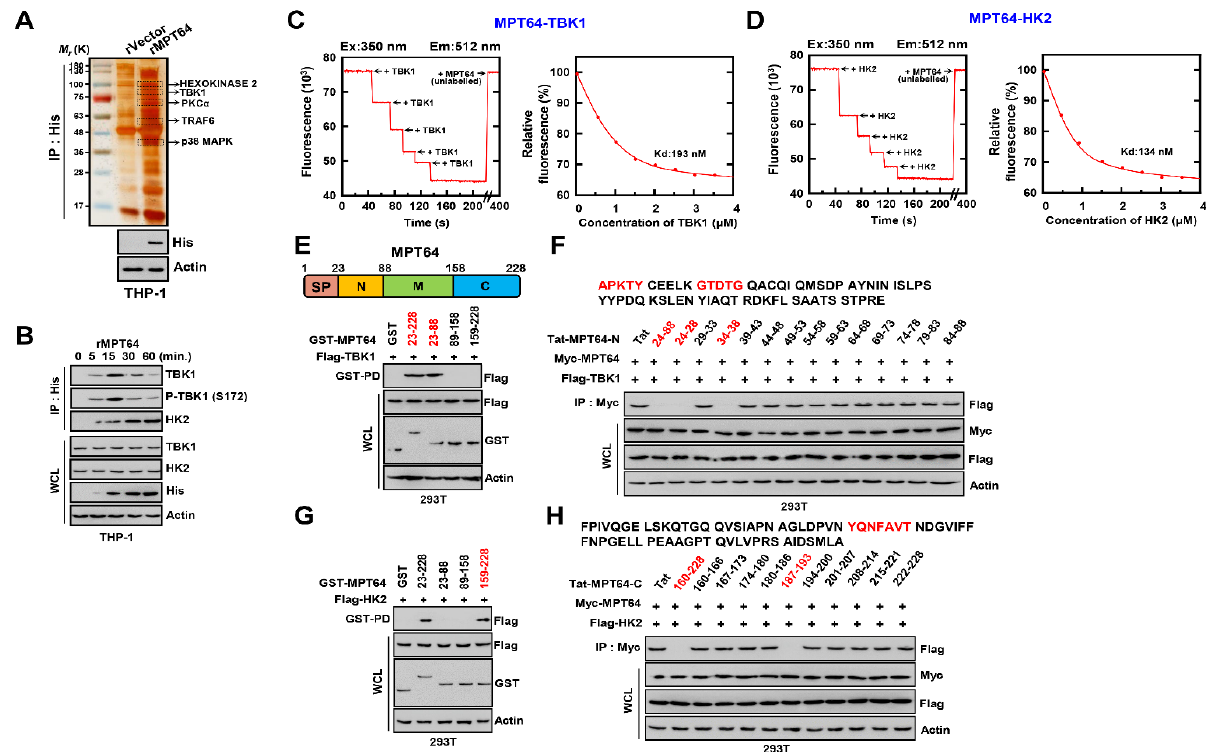
Figure 2. TBK1 and HK2 directly interact with MPT64. ( A ) Identification of TBK1 and HK2 by mass spectrometry analysis in THP-1 cell lysates treated with rMPT64 or rVector. ( B ) THP-1 cells were stimulated with rMPT64 (5 μg mL −1 ) for the indicated times, followed by IP with αHis-agarose bead and IB with αTBK1, αP-TBK1 (S172), αHK2, αHis, αActin. ( C , D ) Titration of fluorescently labelled MPT64 with TBK1 and HK2 (left), with K d (193 and 134 nM), determined by curve fit analysis (right). ( E , G ) Binding mapping. Schematic diagrams of the structures of MPT64 (upper). At 48 h after transfection with GST or GST-MPT63 and truncated mutant constructs together with Flag-TBK1 or V5-p47phox. 293T cells were used for GST pull down, followed by IB with αFlag or αV5. WCLs were used for IB with αFlag or αV5, αGST, and αActin. ( F , H ) 293T cells expressing Myc-MPT63 and Flag-TBK1 or V5-p47phox and treated with several Tat-MPT64-N or MPT64-C peptides (10 µM) for 6 h, followed by IP with αMyc and IB with αFlag. WCLs were used for IB with αMyc, αFlag, and αActin. The data are representative of four independent experiments with similar results ( A – H ).